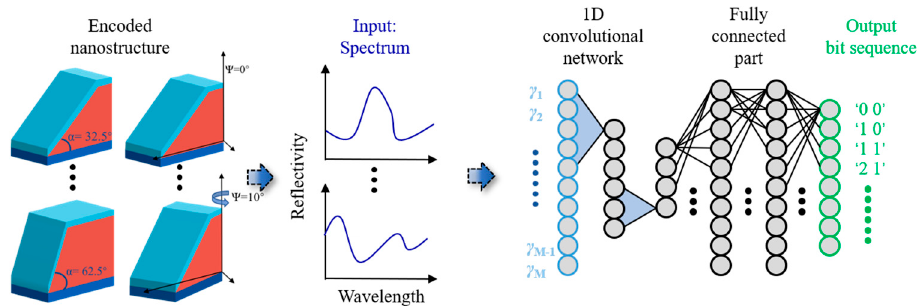
Figure 7. Schematic diagram of a convolutional ANN. The spectra corresponding to the different sloppy structures are used as inputs to ANN; the encoded data information is used as the ANN output.